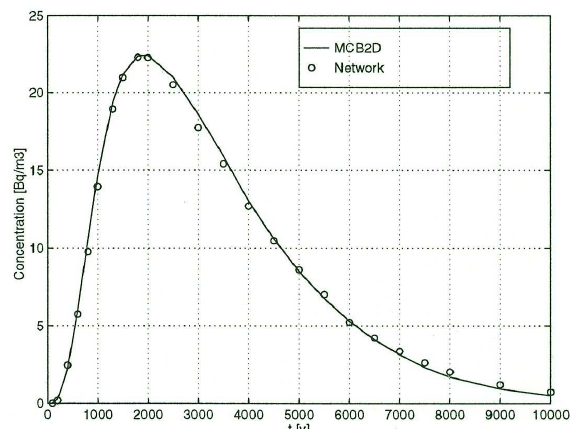
Fig. 4.15. Network with source on node 56, v/R= 8.5 (cid:215) 10 -4 m/d, e test =